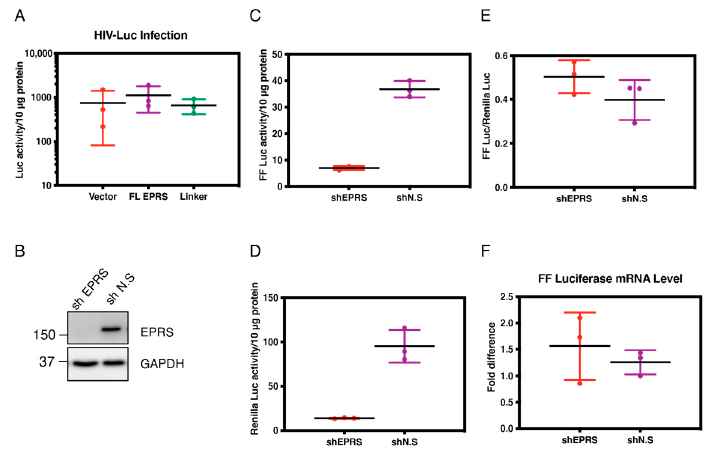
Figure 7. Effect of EPRS on HIV-1 gene expression. ( A ) Relative luciferase activity in HEK293T cells overexpressing full-length (FL)EPRS-flag or linker-flag (as indicated in the Western blot below the graph, probed with anti-flag antibody) and infected by HIV-Luc/VSV-G. ( B ) Stable HEK293T cell lines that allow doxycycline-inducible expression of EPRS-targeting or non-silencing shRNAs (shEPRS and shN.S.) were generated and treated with doxycycline for 72 h. EPRS protein level was measured by immunoblotting. ( C – E ) Luciferase activities in cells infected with HIV-Luc/VSV-G and co-transfected with pRL-TK. Firefly ( C ) and Renilla ( D ) luciferase activity was measured by a dual-luciferase assay. ( E ) To assess HIV-specific effects, Firefly luciferase activity was normalized to Renilla luciferase activity. ( F ) Firefly luciferase mRNA levels in cells infected with HIV-Luc/VSV-G, measured by qRT-PCR. Experiments were performed in triplicate, with the mean value indicated by a horizontal line. Data are shown as luciferase mRNA levels relative to one of the shN.S + HIV samples, which was set to